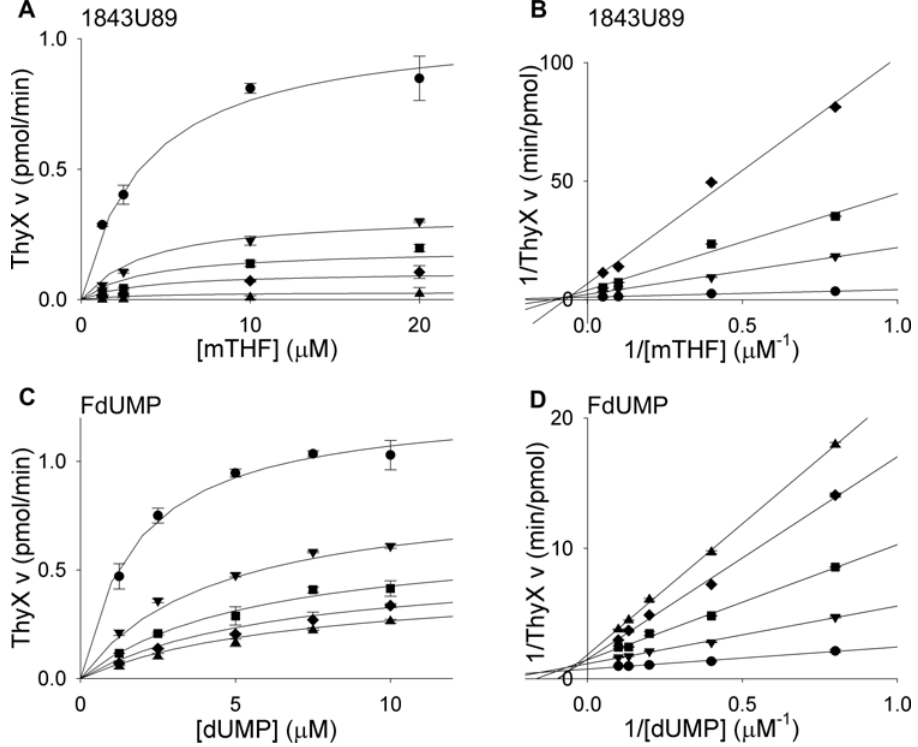
Figure 8. Inhibition of M.tuberculosis ThyX by 1843U89 and FdUMP. (A) Titrations of mTHF (1.25, 2.5, 10, 20 m M) with varying concentrations N , 0 m M; . , 25 m M; & , 50 m M; ¤ , 100 m M; m , 400 m M) in the presence of 2.86 m M dUMP. (B) Double reciprocal plot of data from plot A of 1843U89 ( showing a noncompetitive inhibition mechanism. (C) Titrations of dUMP (1.25, 2.5, 5, 7.5, 10 m M) with varying concentrations of FdUMP ( 250 nM; & , 500 nM; ¤ , 750 nM; m , 1000 nM) in the presence of 8 m M mTHF. (D) Double reciprocal plot of data from plot C showing a mixed inhibition mechanism. Lines in A and C are plots of Michaelis-Menten equations with calculated constants. Lines in B and D are linear regressions. Error bars are propagation of standard deviations.